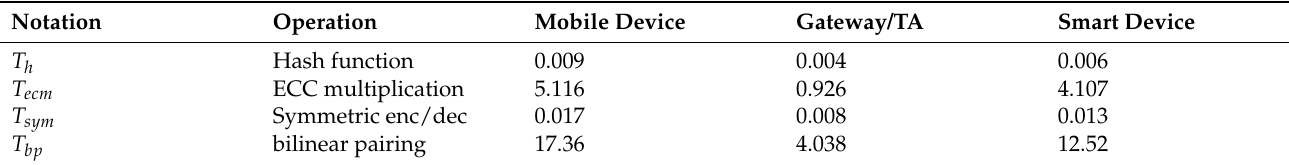
Table 8. Approximate computation time of various operations.